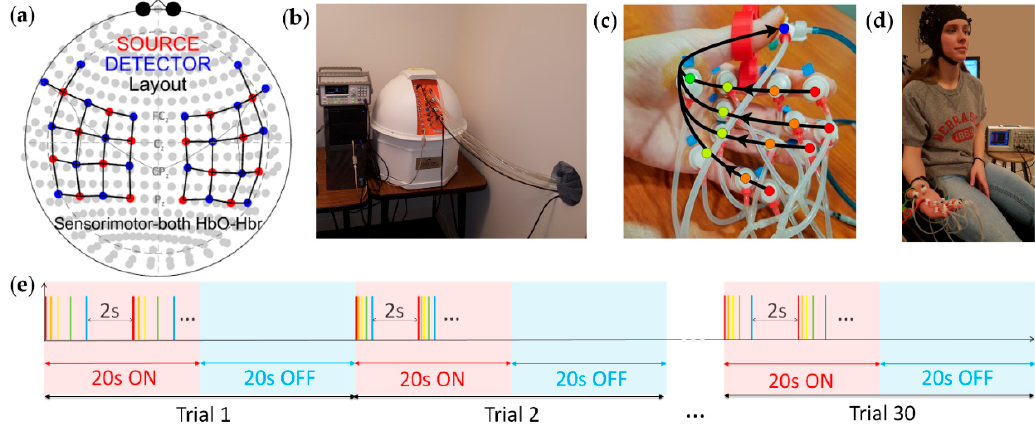
Figure 1. Experiment Design: ( a ) fNIRS optode layout. Blue dots are light sources, red dots are detectors and grey dots are five-percent distance increments in the standard 10–20 system. Each line is a link (channel). ( b ) Galileo ™ pneumotactile stimulus control system housed in a sound-isolated room adjacent to the fNIRS recording suite to minimize its acoustic noise. ( c ) Color-coded TAC-cells and the arrows show the order and direction of the saltation wave at each node. Each wave starts at D2–D5 fingertips (red nodes) and terminates at the thumb (blue node). The time interval between two consecutive nodes depends on the velocity and hand measurements. ( d ) Participant configured with the fNIRS cap while receiving the somatosensory stimulus. ( e ) Stimulus pulse train color-coded to match channel assignment. Each node delivers a 60 ms pulse. Each stimulus pulse train consists of five 60 ms pulses at varying intervals based on the velocity and hand measurements. Each trial lasts 40 s, consisting of 20 s of stimulus in the form of repeated pneumatic pulse trains with 2 s interburst intervals, followed by 20 s of no stimulation. There are 10 trials per velocity, resulting in 30 trials per task. Each trial is immediately followed by another in a random-balanced velocity design.